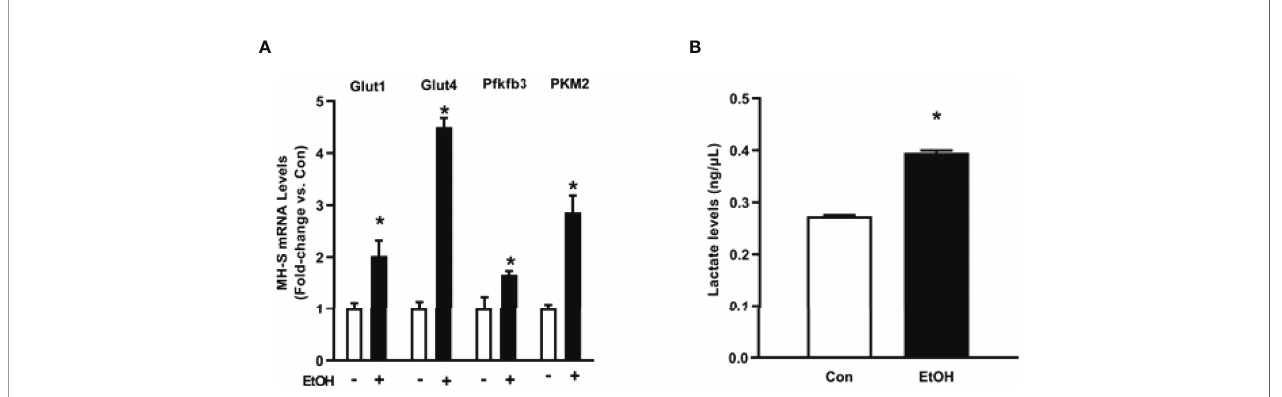
FIGURE 3 | Ethanol increases expression of glycolytic proteins and lactate levels in MH-S. MH-S were exposed to either control (Con) or ethanol (EtOH; 0.08%) for 72 hours. (A) mRNA levels of glucose transporter (Glut)1, Glut4, 6-phosphofructo-2-kinase/fructose-2,6-bisphosphatase 3 (Pfkfb3), and pyruvate kinase 2 (PKM2) were measured by qRT-PCR, in duplicate, normalized to GAPDH, and are expressed as mean±SEM, relative to control. (B) Protein isolated from MH-S cells was used to evaluate lactate levels via lactate assay kit and are expressed as mean±SEM, relative to control (n = 4-6). * p < 0.05 versus